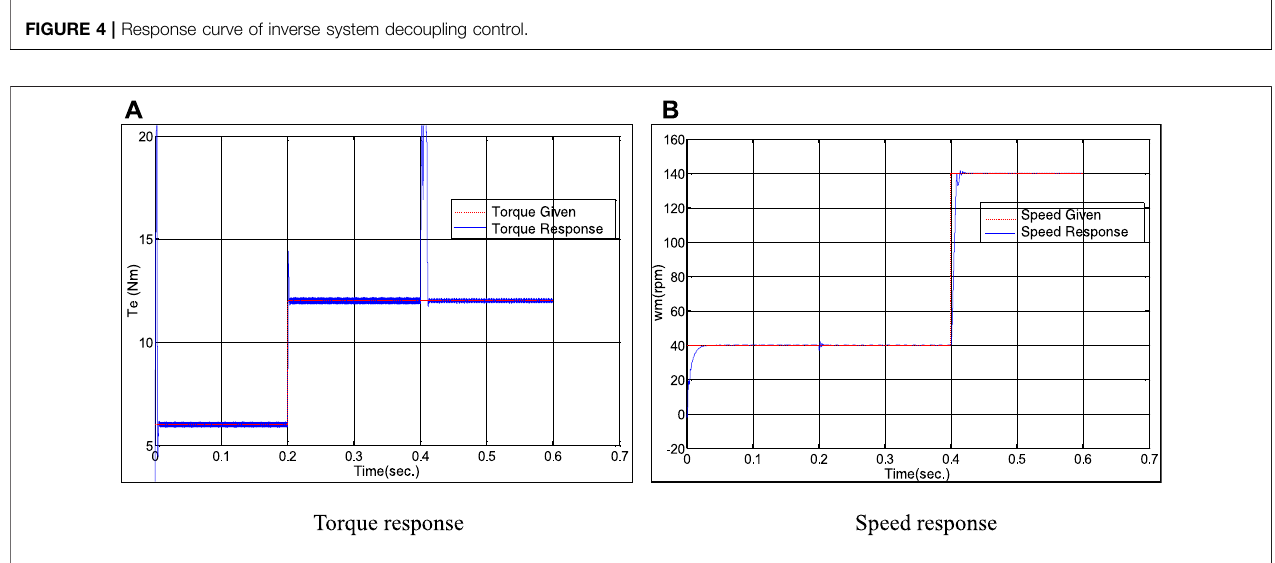
FIGURE 5 | Response curve of BPNN inverse system decoupling control.